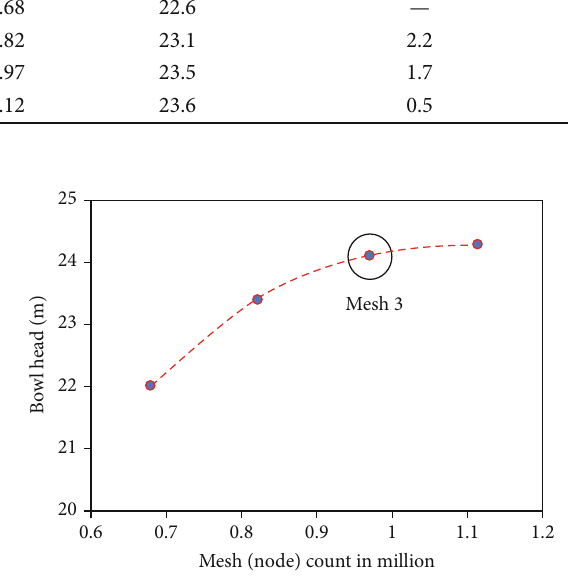
Figure 3: Mesh independent study (CFD) of the